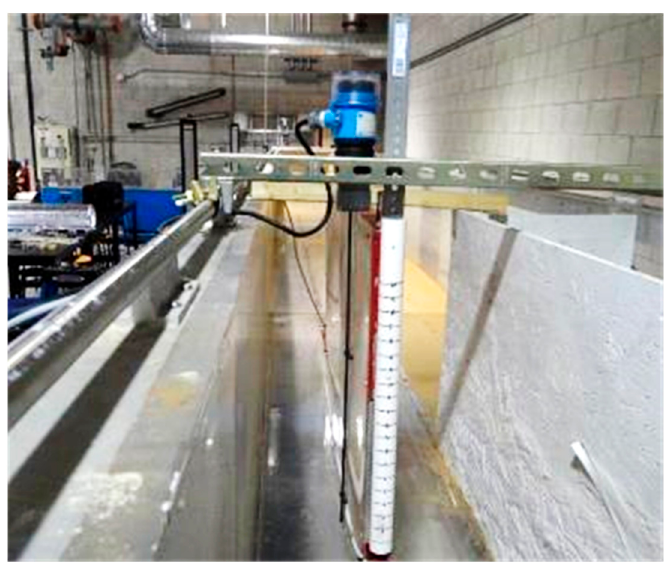
Figure 6. Level meter location in the flume. Figure 7. Level meter location in the